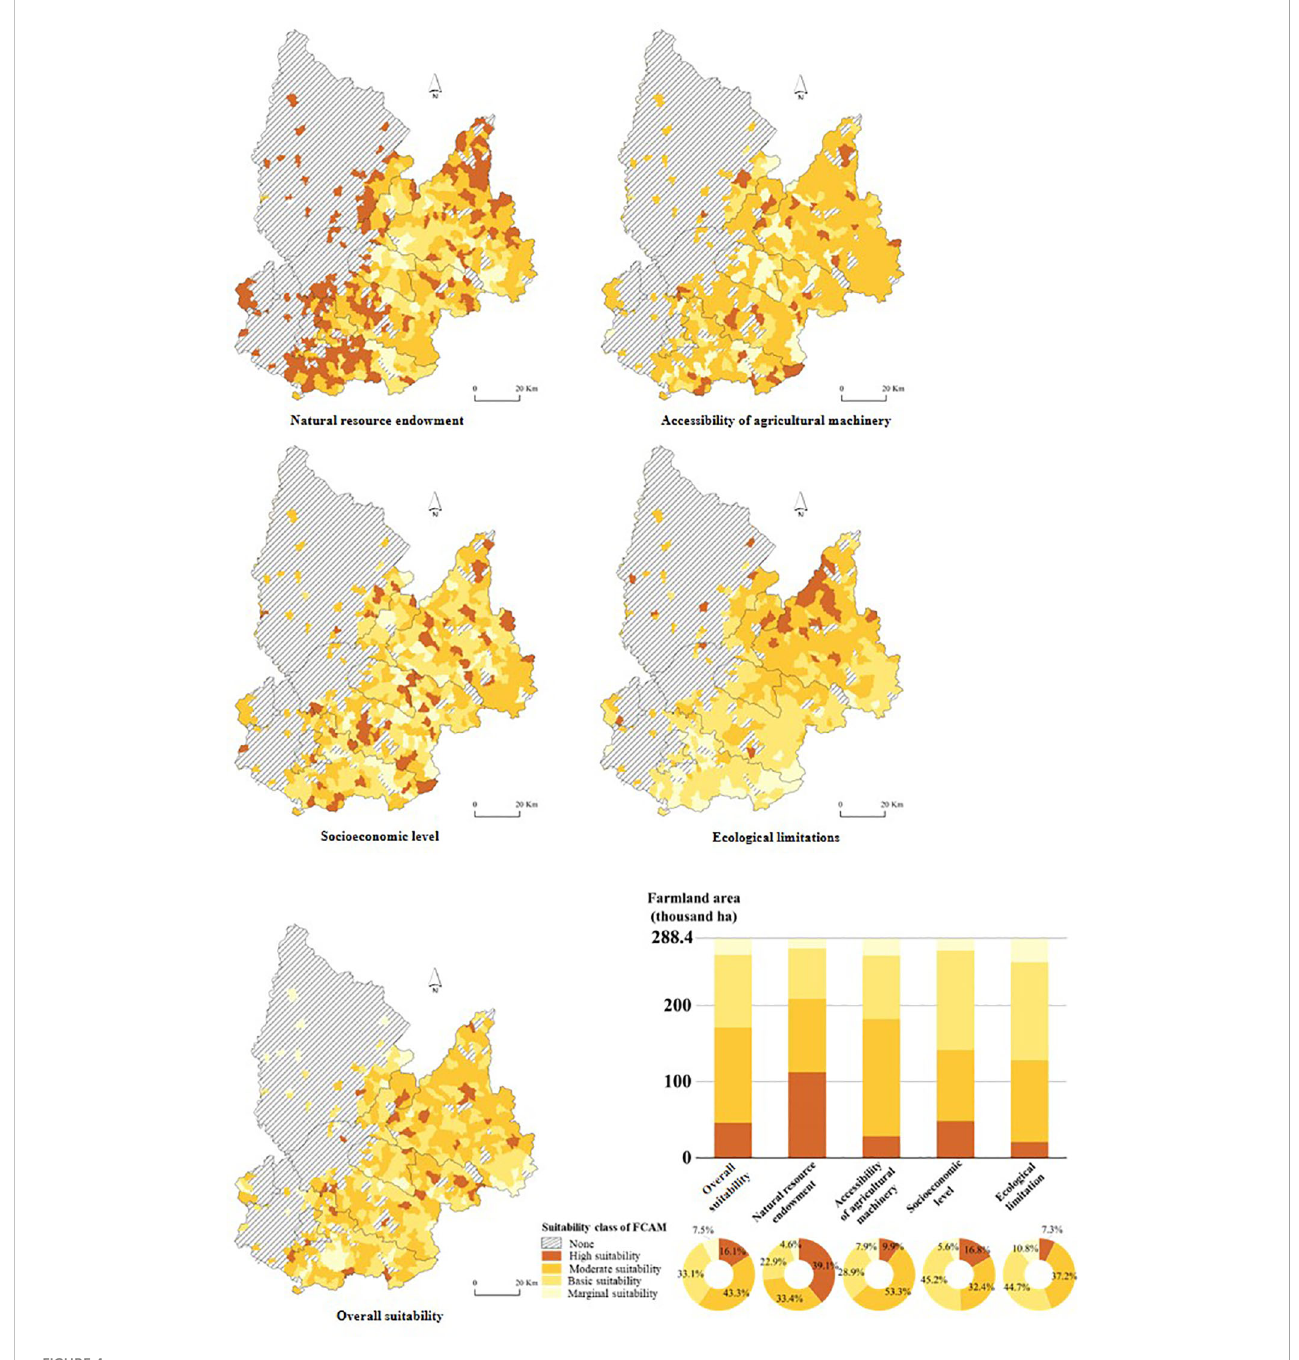
FIGURE 4 Suitability class of FCAM. FCAM, farmland consolidation suitable for agricultural